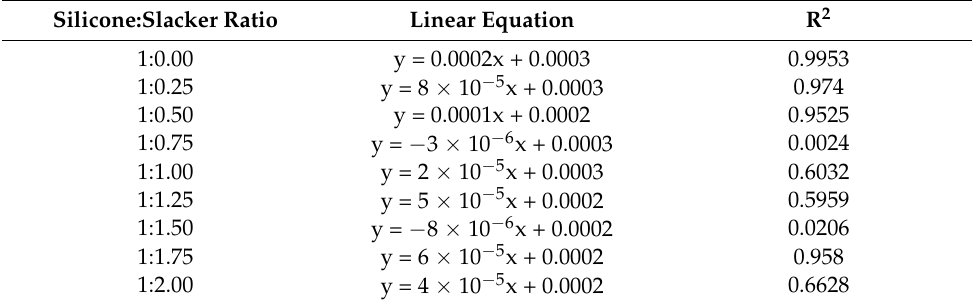
Table A4. Equations and R 2 values for individual trendlines in Figure 1d.